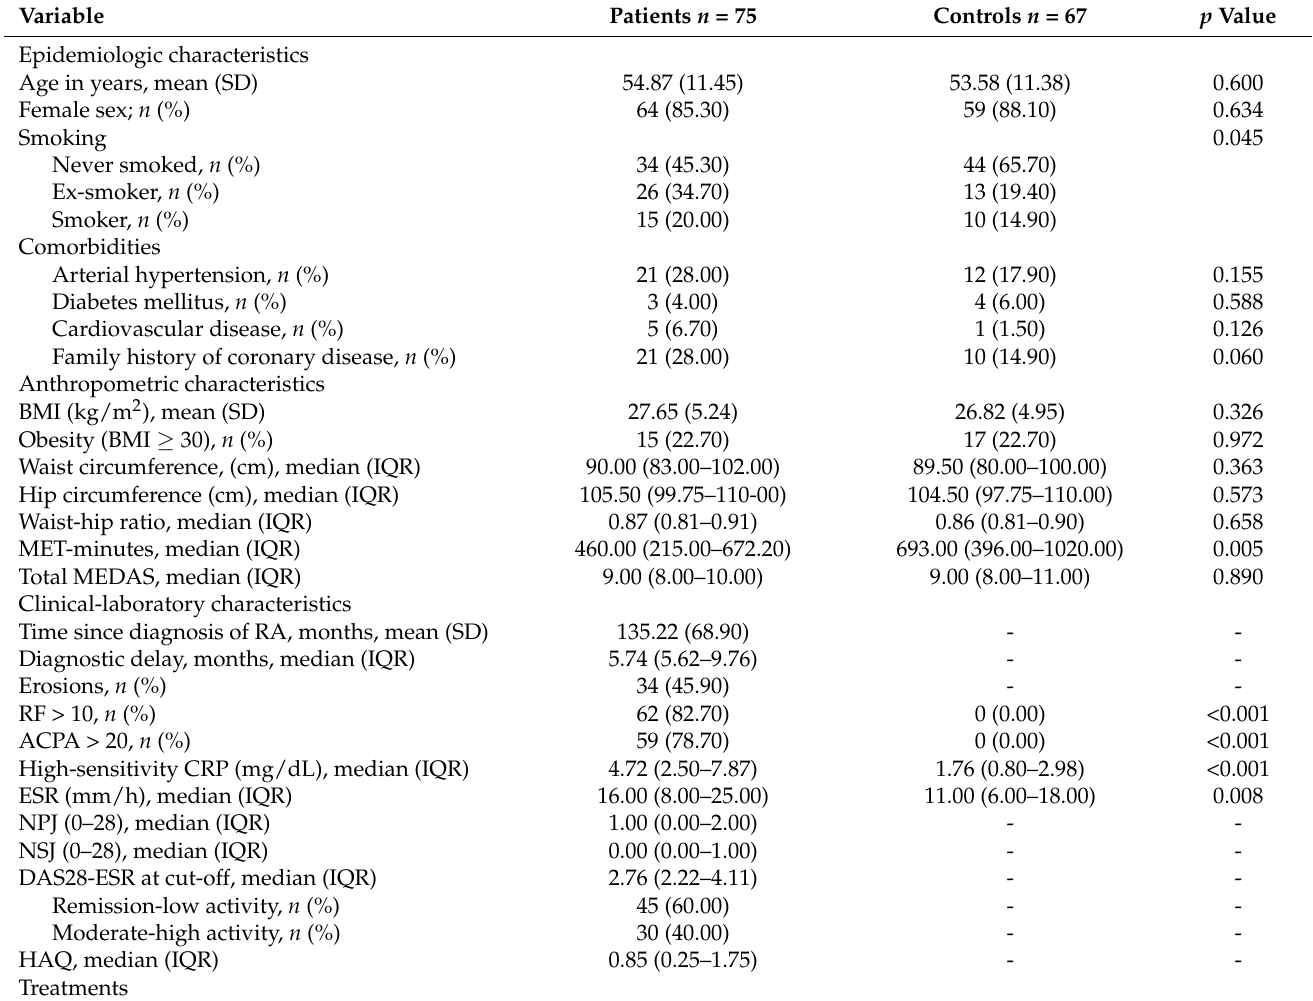
Table 1. Clinical–analytical characteristics of 75 patients with RA and 67 controls.